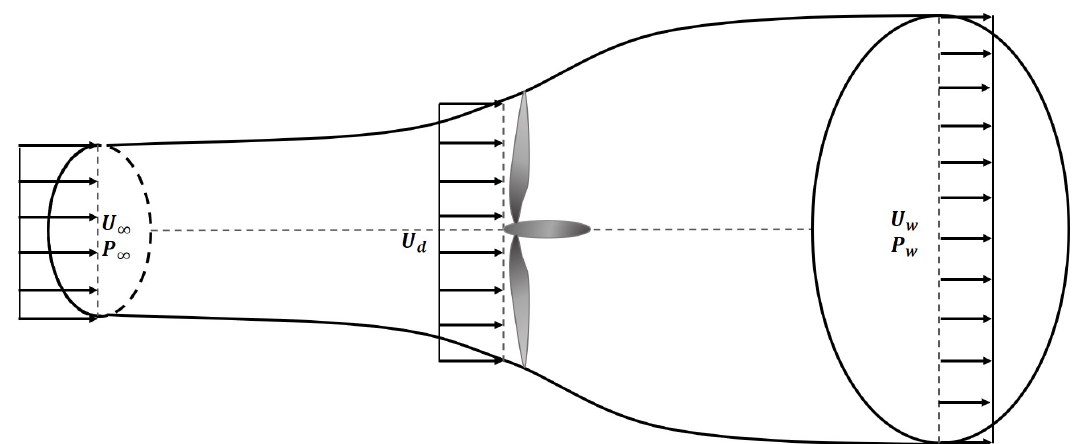
Figure 4. The stream-tube containing the wind turbine expands in the axial direction due to the fact that wind speed decreases gradually from the inflow towards the far